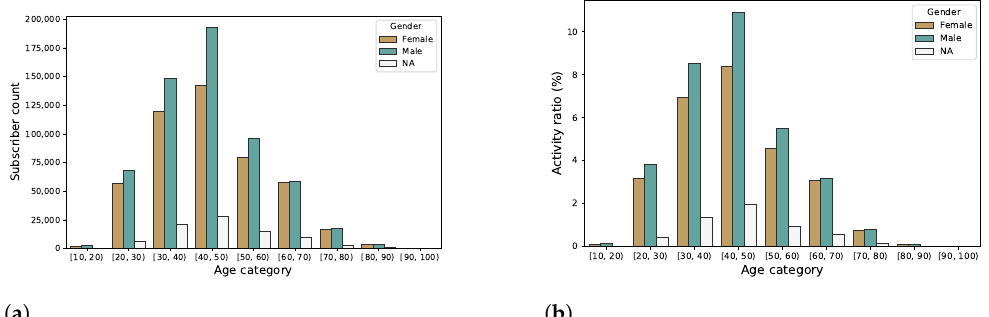
Figure 4. The number of cell phone subscribers ( a ), and the ratio of all mobile network activity ( b ) by age category, when the subscriber age is known.